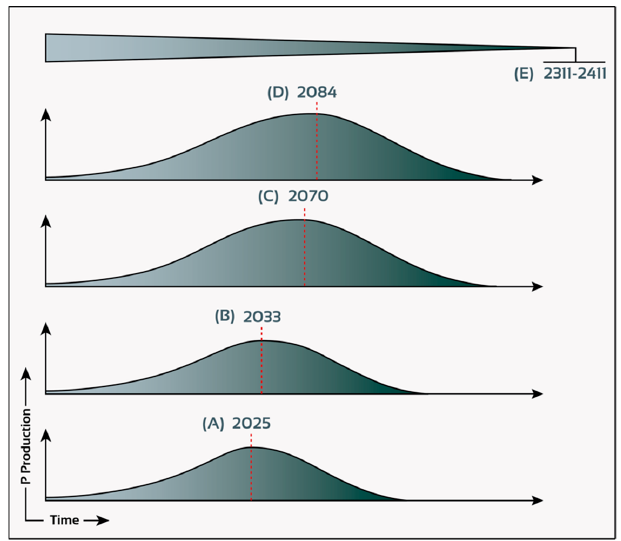
Figure 10. Future projections of phosphate rock production, with different estimates of the so-called phosphorus peak according to: A [113], B [114], C [11], D [115], and E